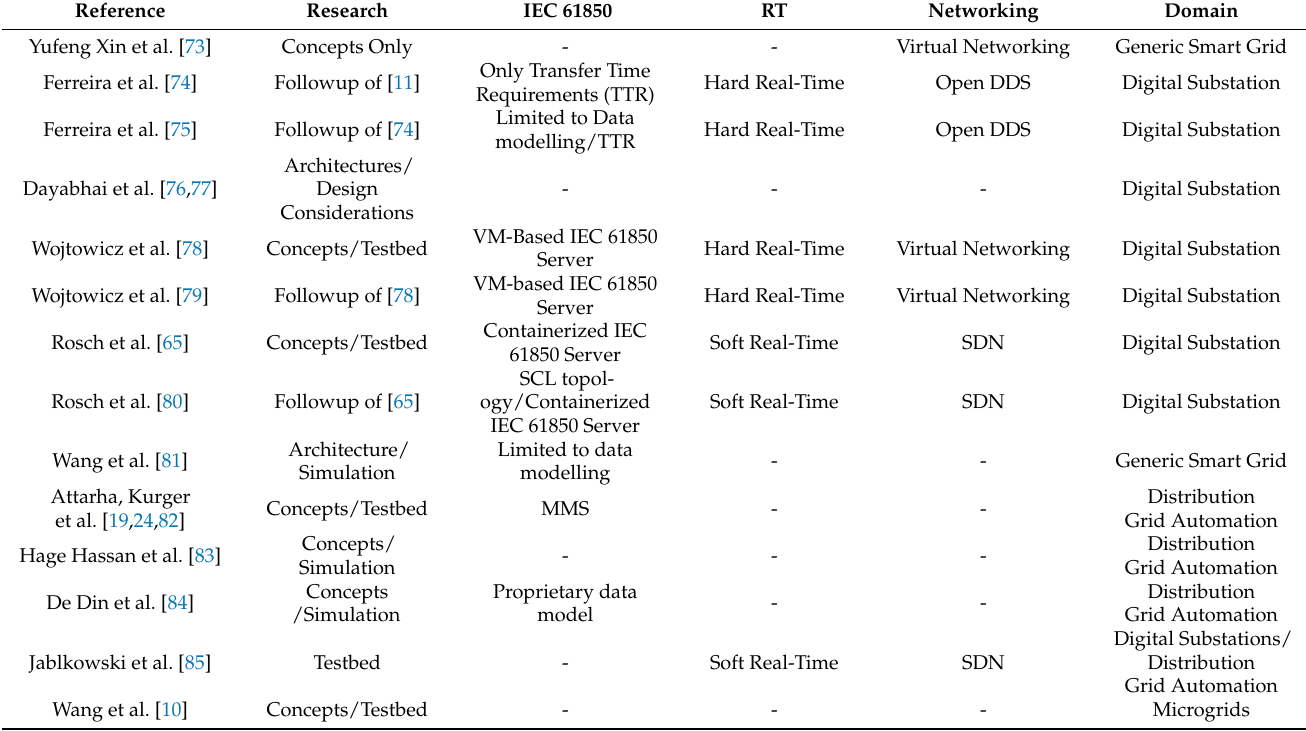
Table 3. Academic Research Articles on virtualized PAC